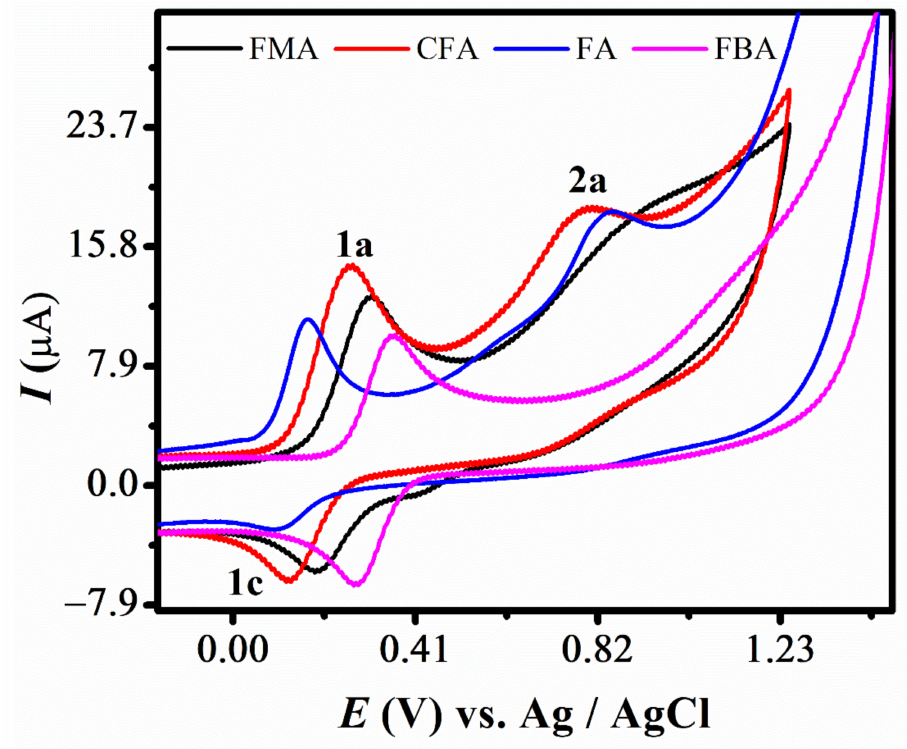
Figure 1. CVs of 2 mM ferrocene derivatives in pH 7 at 0.1